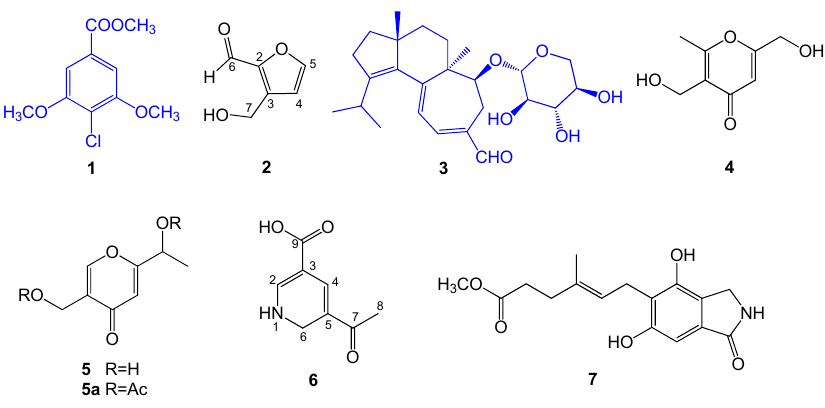
Figure 1. Structures of compounds 1 – 7 from Hericium erinaceus .